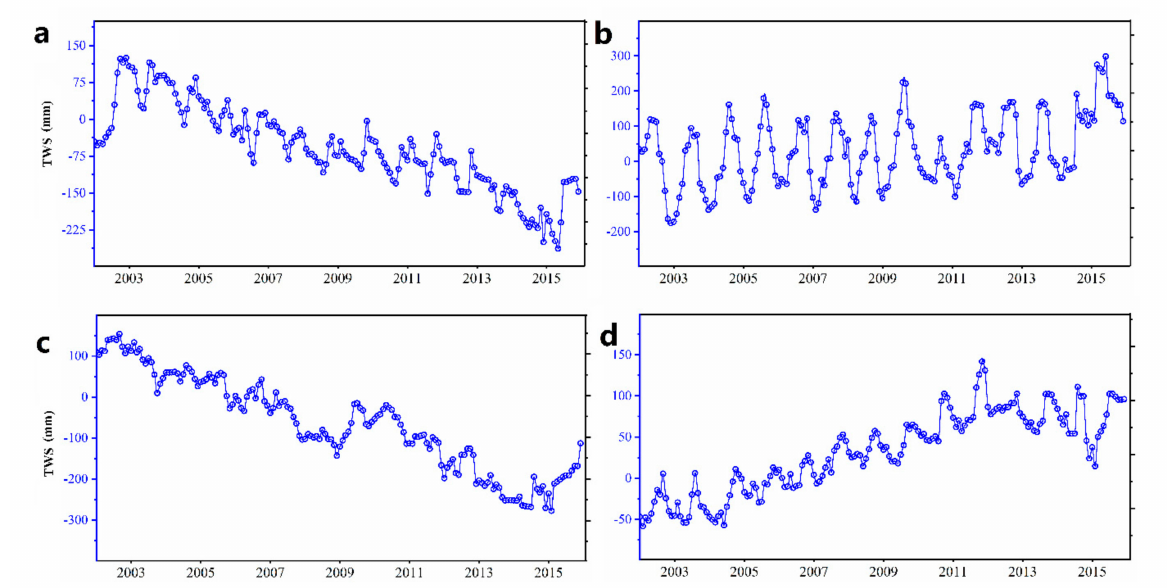
Figure 6. Temporal profiles of terrestrial water storage over the four hotspots. ( a ) North China; ( b ) South China; ( c ) Tianshan Mountains; ( d ) the Interior of the Tibetan